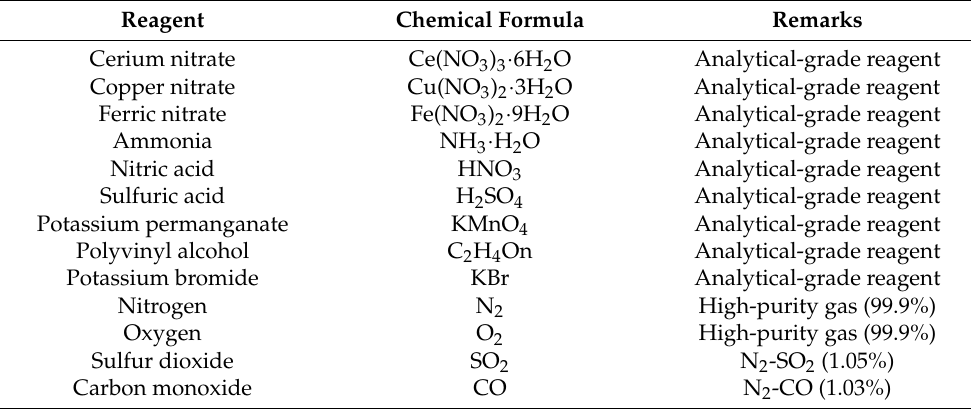
Table 1. Main reagents used in the experiment.